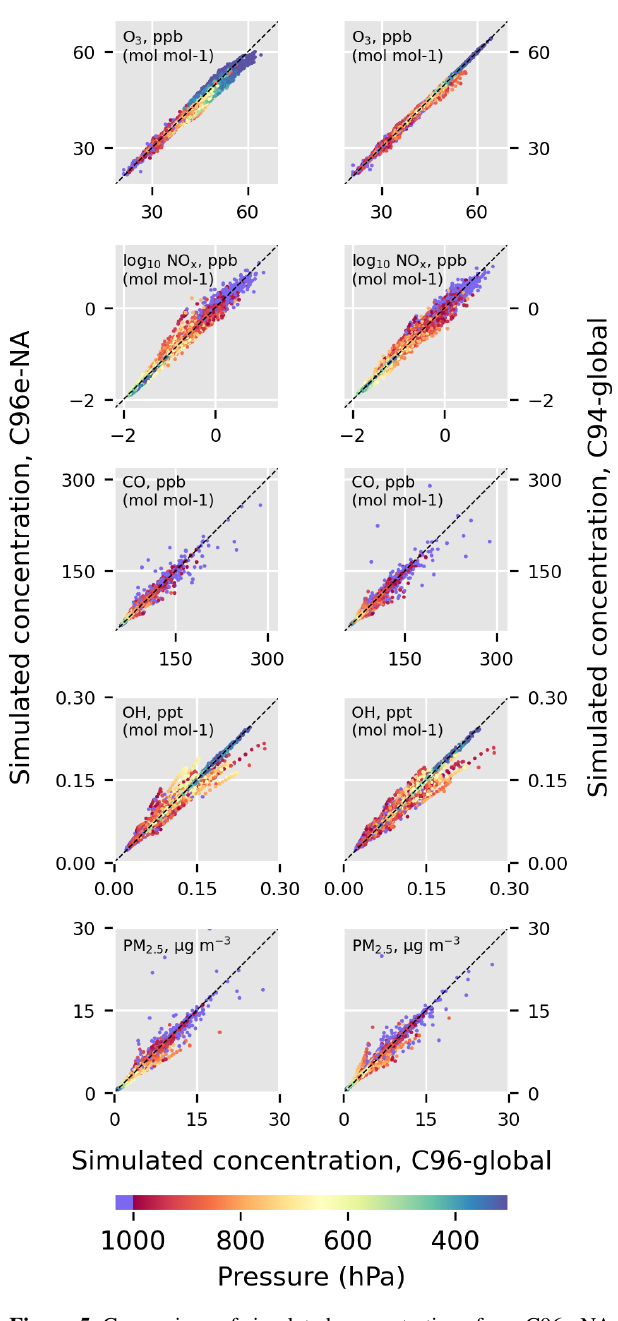
Figure 5. Comparison of simulated concentrations from C96e-NA with C96-global, and C94-global with C96-global. Points are 1- month time averages for each grid box in the contiguous US for the fourth simulation month (September 2018). The right column gauges expected differences due to the precision of upscaling emis- sions to different grids. Concentrations in the lowermost model level are shown in purple.